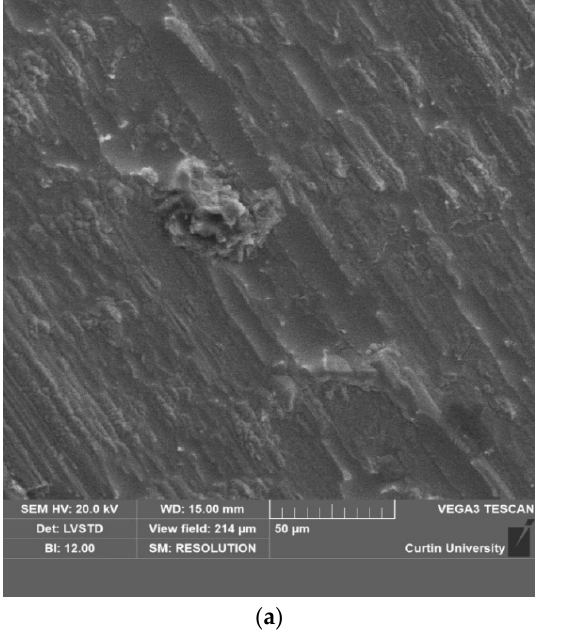
Figure 11. Toughness of AMF reinforced cement and geopolymer concrete at elevated temperature.